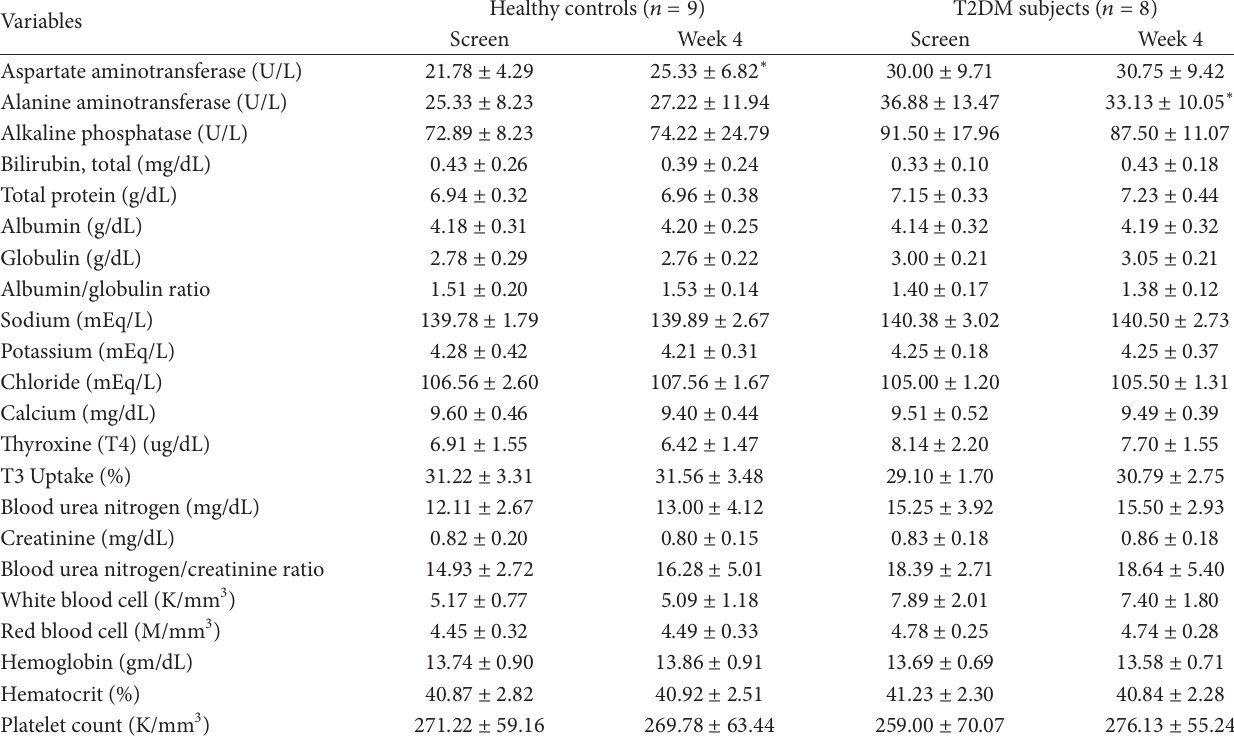
1 Data are mean ± SD; T2DM: type 2 diabetes mellitus. Table 4: Effects of POMx supplementation on safety parameters 1